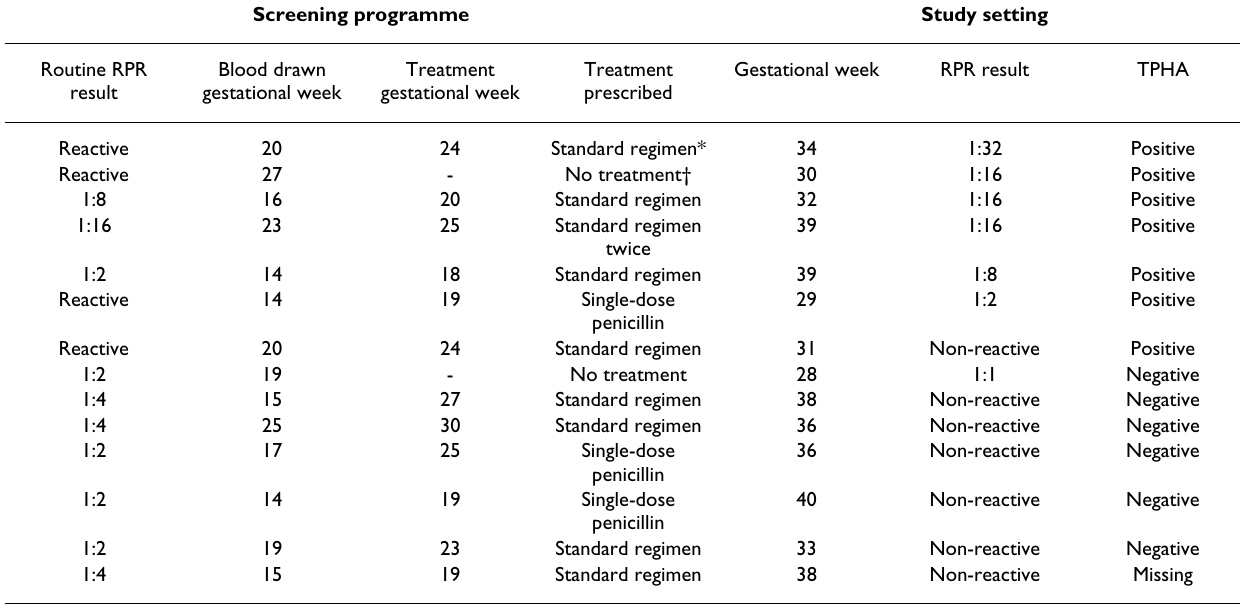
*Botswana guidelines for the management of RPR/VDRL positive cases (regardless of titre): Three injections with benzathine penicillin 2.4 million units at weekly intervals. †The patient came for the third antenatal care